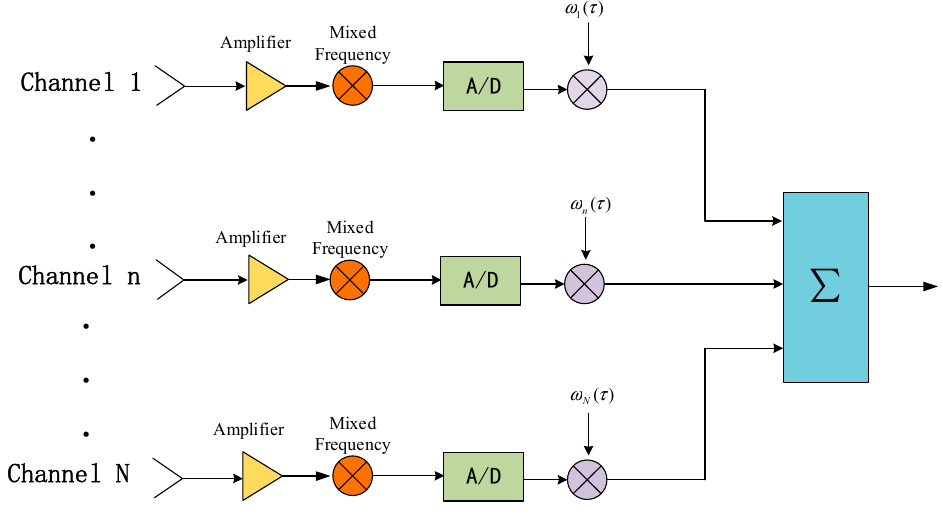
Figure 2. DBF block diagram.